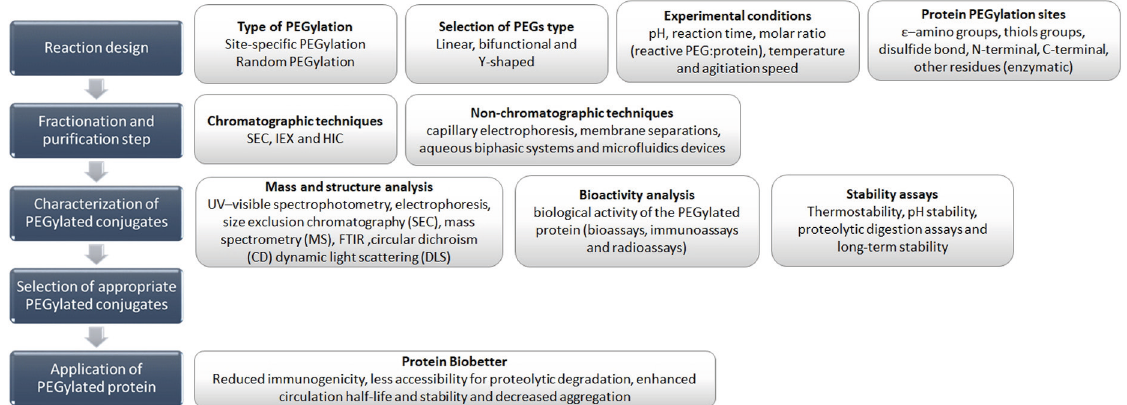
FIGURE 11 - Flow diagram of the PEGylation bioprocess operation from reaction design to purification and characterization, ending up with the final application of the chemically modified protein drugs as an effective